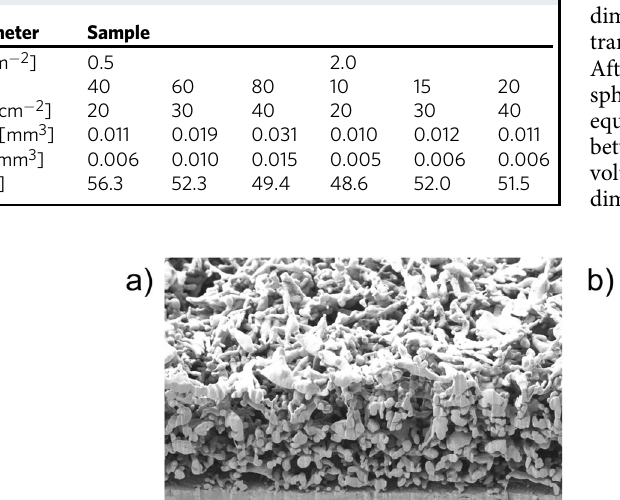
Table 2 Calculated porosity of the foam electrodes by laser confocal scanning microscopy data of all foam electrodes.